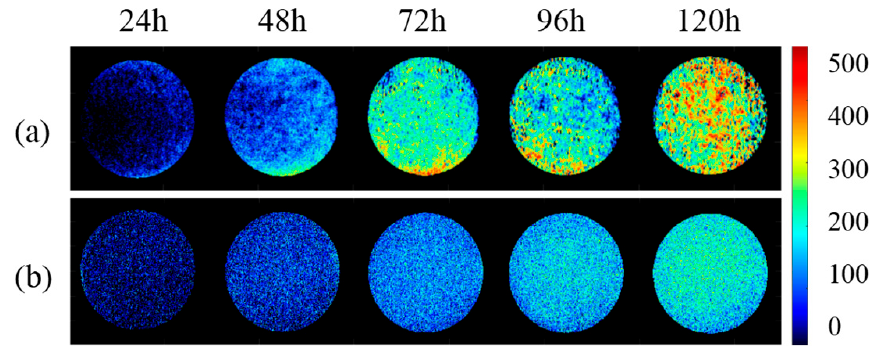
Figure 7. AFB 1 prediction results of the multispectral PLSR model. MAM inoculated ( a ) NRRL 3357 with concentration of 10 2 spores mL − 1 ; ( b ) NRRL 3357 with concentration of 10 4 spores mL − 1 . The changes in the levels of AFB 1 over time were easily observed from the prediction image. The level of AFB1 production, when inoculated with a low concentration of conidia, became higher than that when inoculated with a high concentration of conidia (top rows in Figure 7), which was consistent with the quantitative chemical analysis of AFB 1 concentration using the HPLC. The results indicated that the optimal model